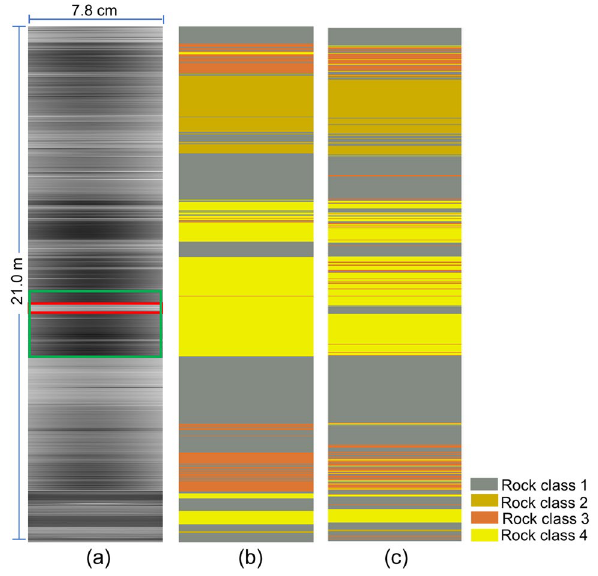
Fig. 16 Predicted rock classes on the test section of the well (approximately 21 meters) ( c ), shown with actual rock classes ( b ) and the 2D cross section of the input CT images ( a ). The scaled-up classifier is predicting the rock classes with high accuracy